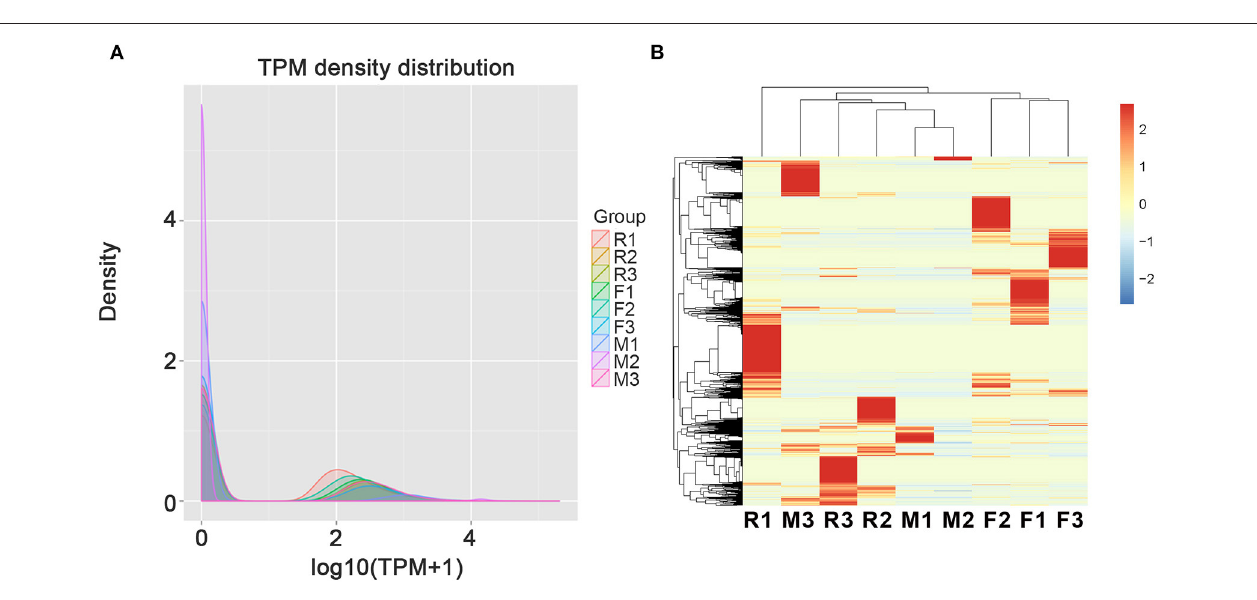
FIGURE 2 | The total expression profile of the three individuals from female (F1–F3), male (M1–M3), and sex-changed (R1–R3) tilapias. (A) The expression profiles determined by TPM density of circRNAs in the gonads of female, male, and sex-changed tilapias. (B) Heatmap of circRNAs in the gonads of female, male, and sex-changed